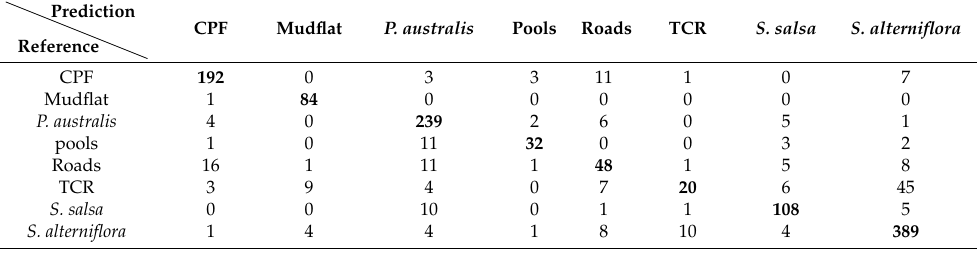
Figure A1. The matrix of the OOB estimate of the error rate with different combinations of mtry and ntree. Table A1. Accuracy assessment for the initial land cover classification map using the random forest algorithm based on the confusion matrix method. TCR: Tidal Channel and River. CPF: Culture Pond and Farmland.